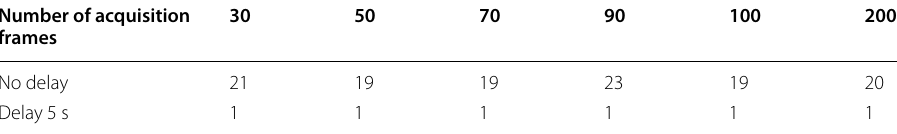
Table 3 Mean available start frame Number of acquisition